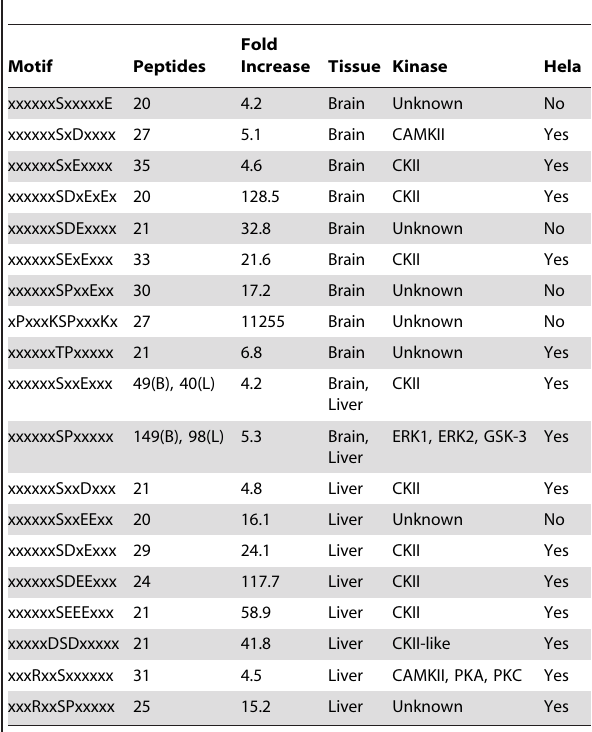
Table 2. Differential phosphorylation motifs identified in the liver and